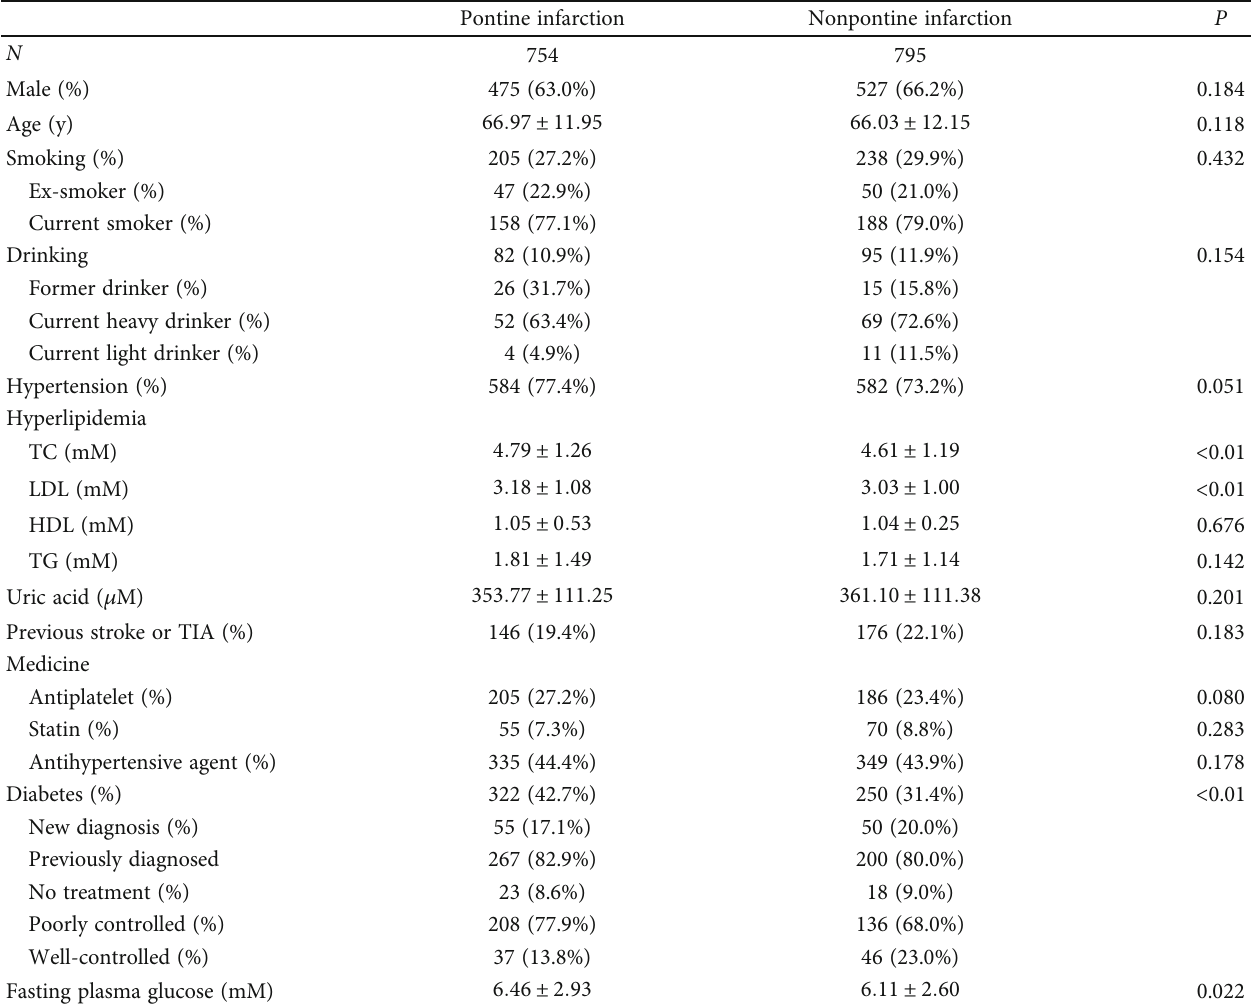
Figure 1: Flow Table 1: Pontine infarction vs. nonpontine infarction.